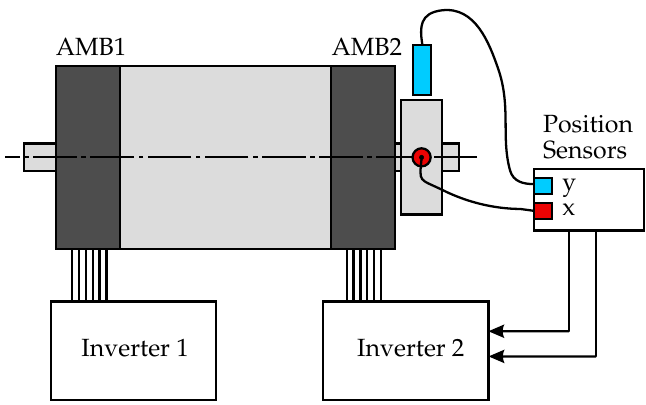
Figure 14. Symbolic arrangement of the test setup with external position sensors according to Figure 4.